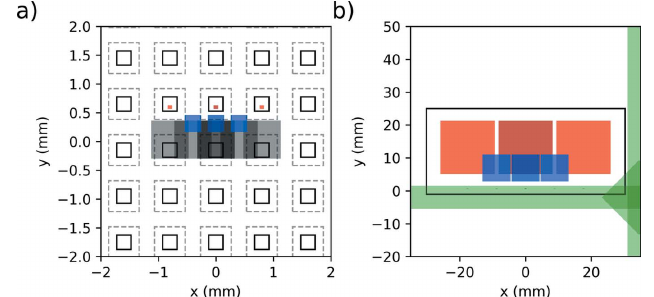
Figure 3 BOZ calculator showing the beams at ( a ) the sample and ( b ) the detector planes. The focused 1st zone-plate order beam footprint at the respective positions is shown as red for the fundamental and blue for the second harmonic. The 0th zone plate order is shown as gray. Individual membrane windows and the etching lines are shown in ( a ) as continuous and dashed lines, respectively. In ( b ) the DSSC sensor is represented by the black rectangle and the DSSC filter mount is represented by the green